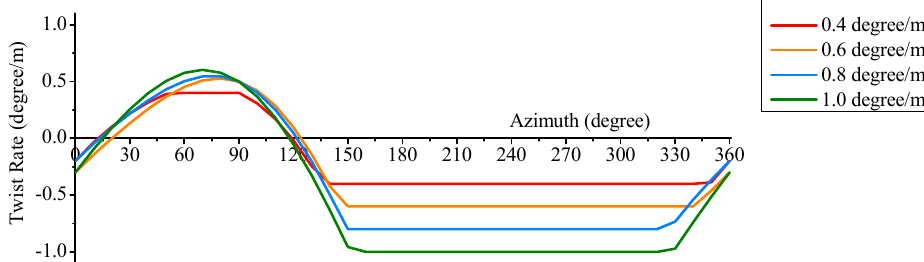
Figure 28. Optimal control schedules of the uniform twist control with saturation limits for condition B.